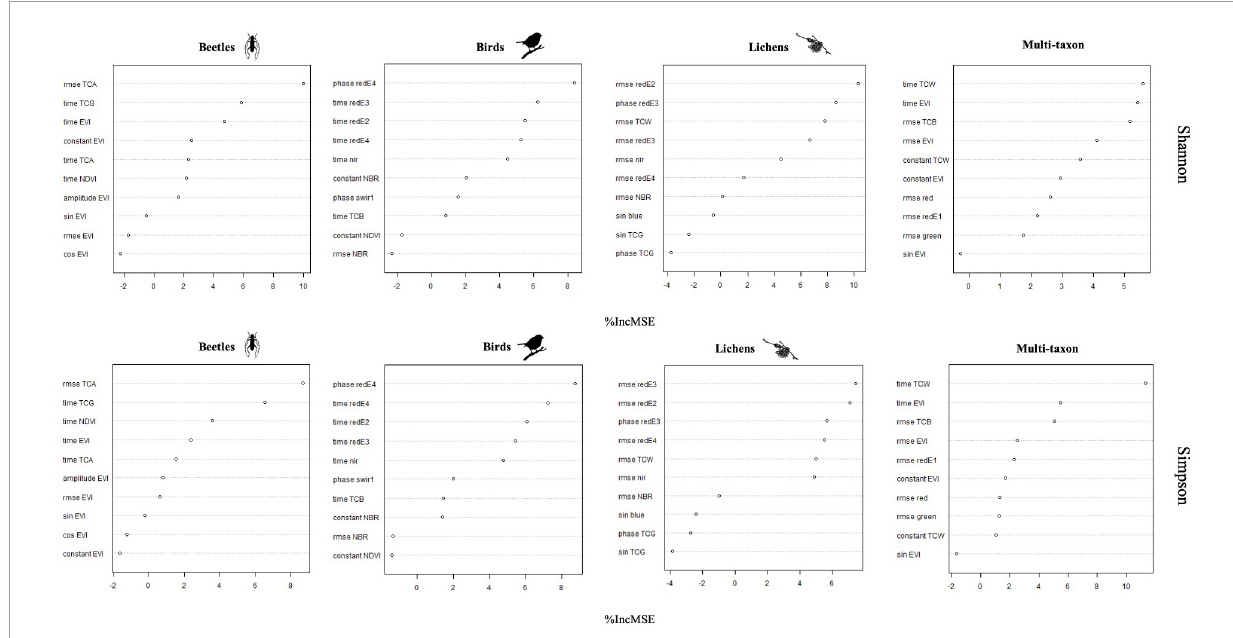
FIGURE6 Variables importance for each of the eight random forests (RF)